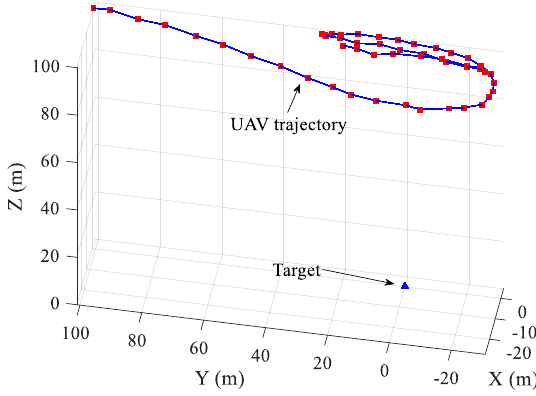
Figure 14. Relative trajectory result for the scenario with a minimum velocity of 5 m/s.